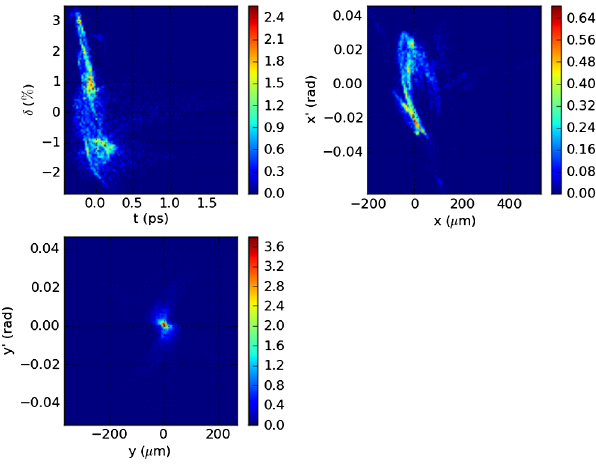
FIG. 6. The histograms of 6D phase space at the final focus point of the compressor. The color bar shows the particle